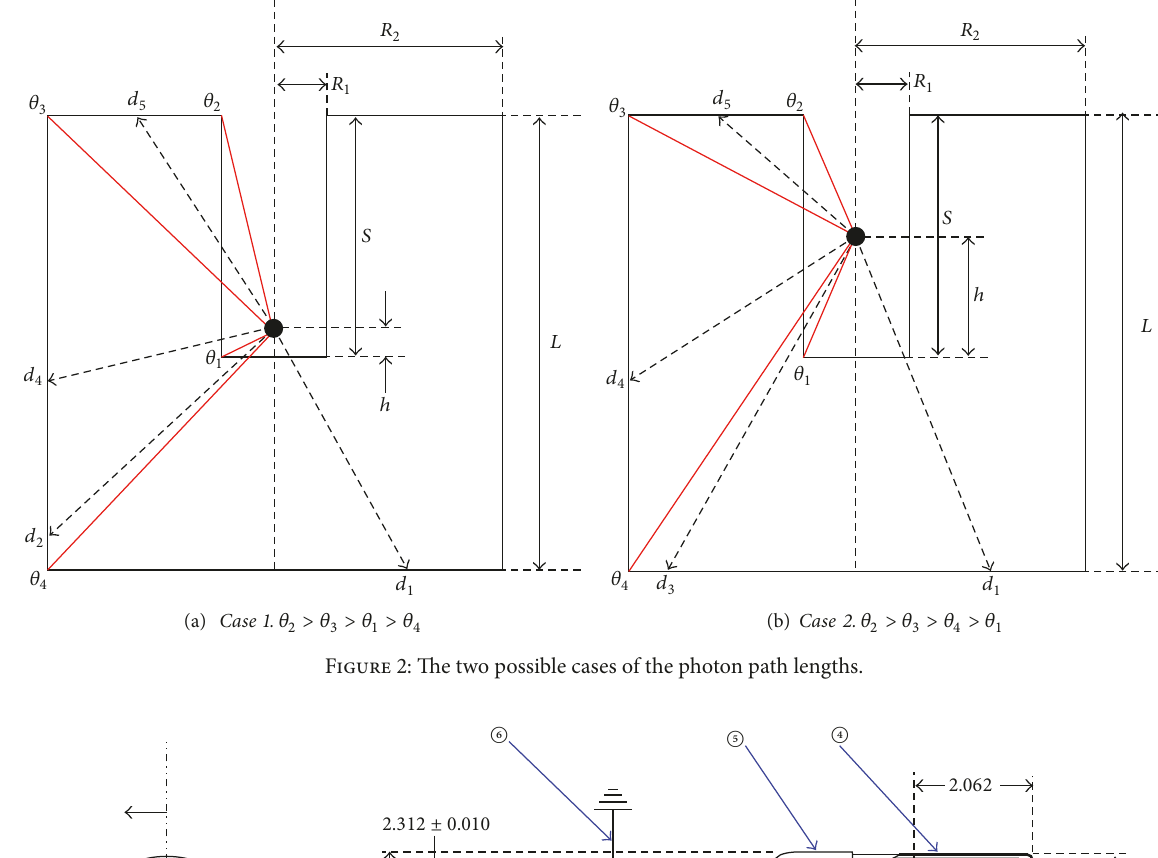
Figure 2: The two possible cases of the photon path lengths.